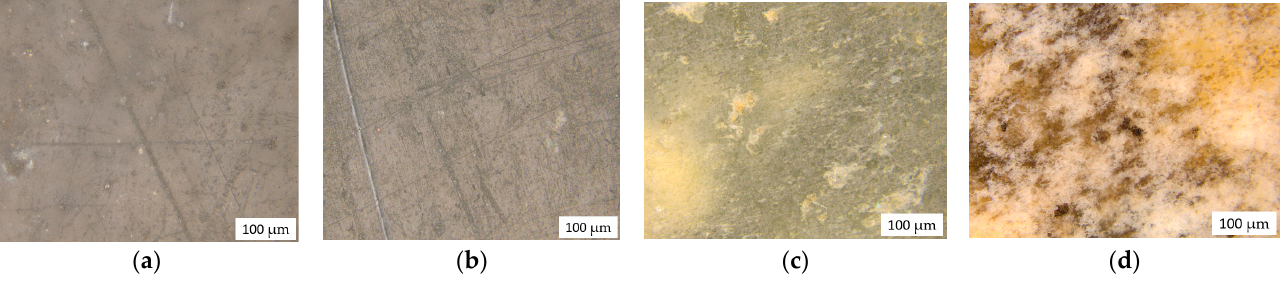
Figure 8. The microphotographs of samples after exposure in the soil: LDPE 100 ( a ), LDPE/NR 90/10 ( b ), LDPE/NR 70/30 ( с ), LDPE/NR 50/50 ( d ). Samples with a content of 30 and 50% have the greatest visible changes compared to